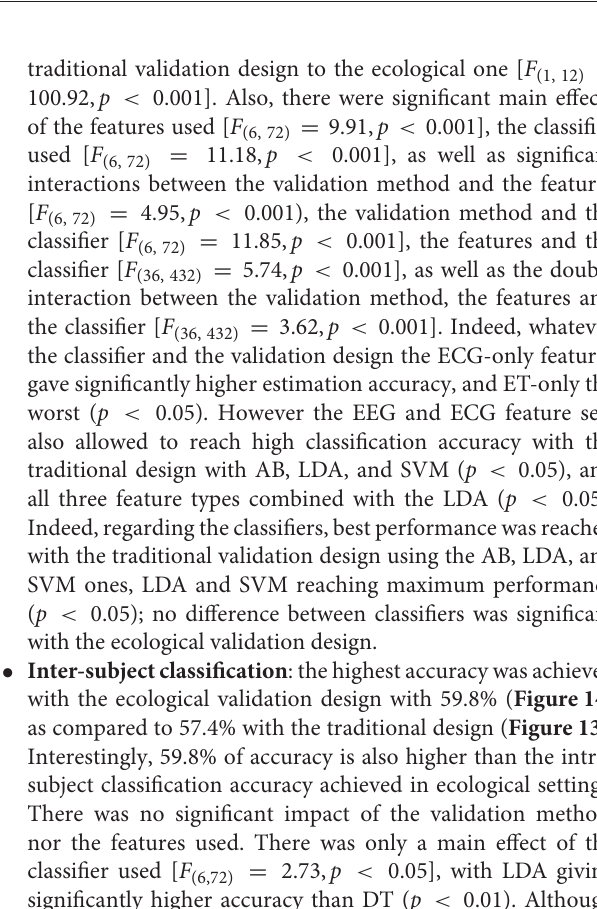
3.37, p < 0.01]. Hence, the EI significantly increased with load at the FC5, FC6, T7, T8, CP5, and P8 electrode sites ( p <